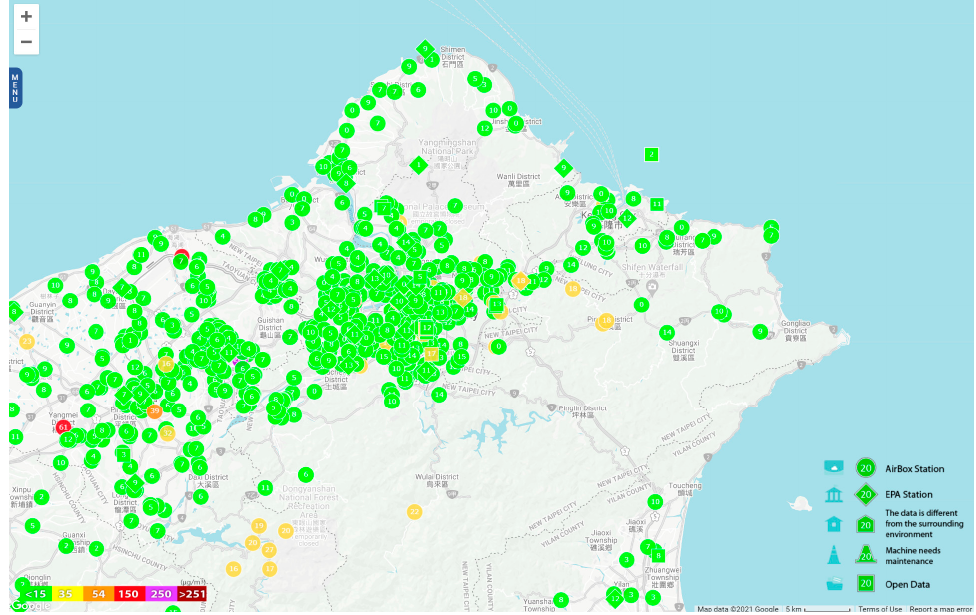
Figure 1. Real-time map of monitored PM2.5 (https://airbox.edimaxcloud.com/ (accessed on 27 May 2021)).